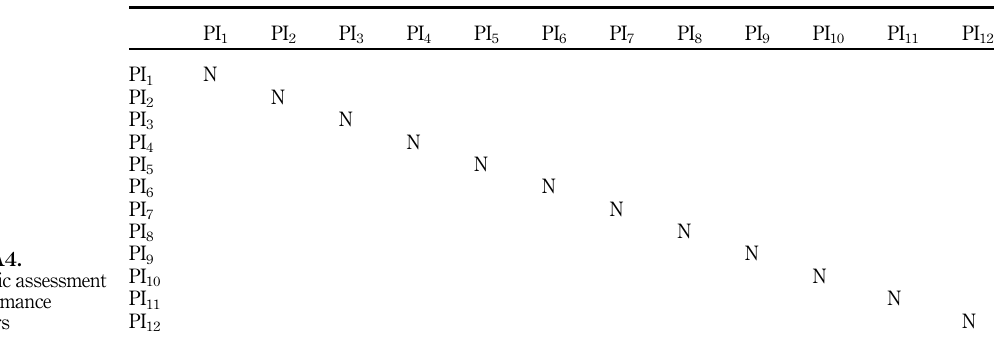
Table A4. Linguistic assessment of performance